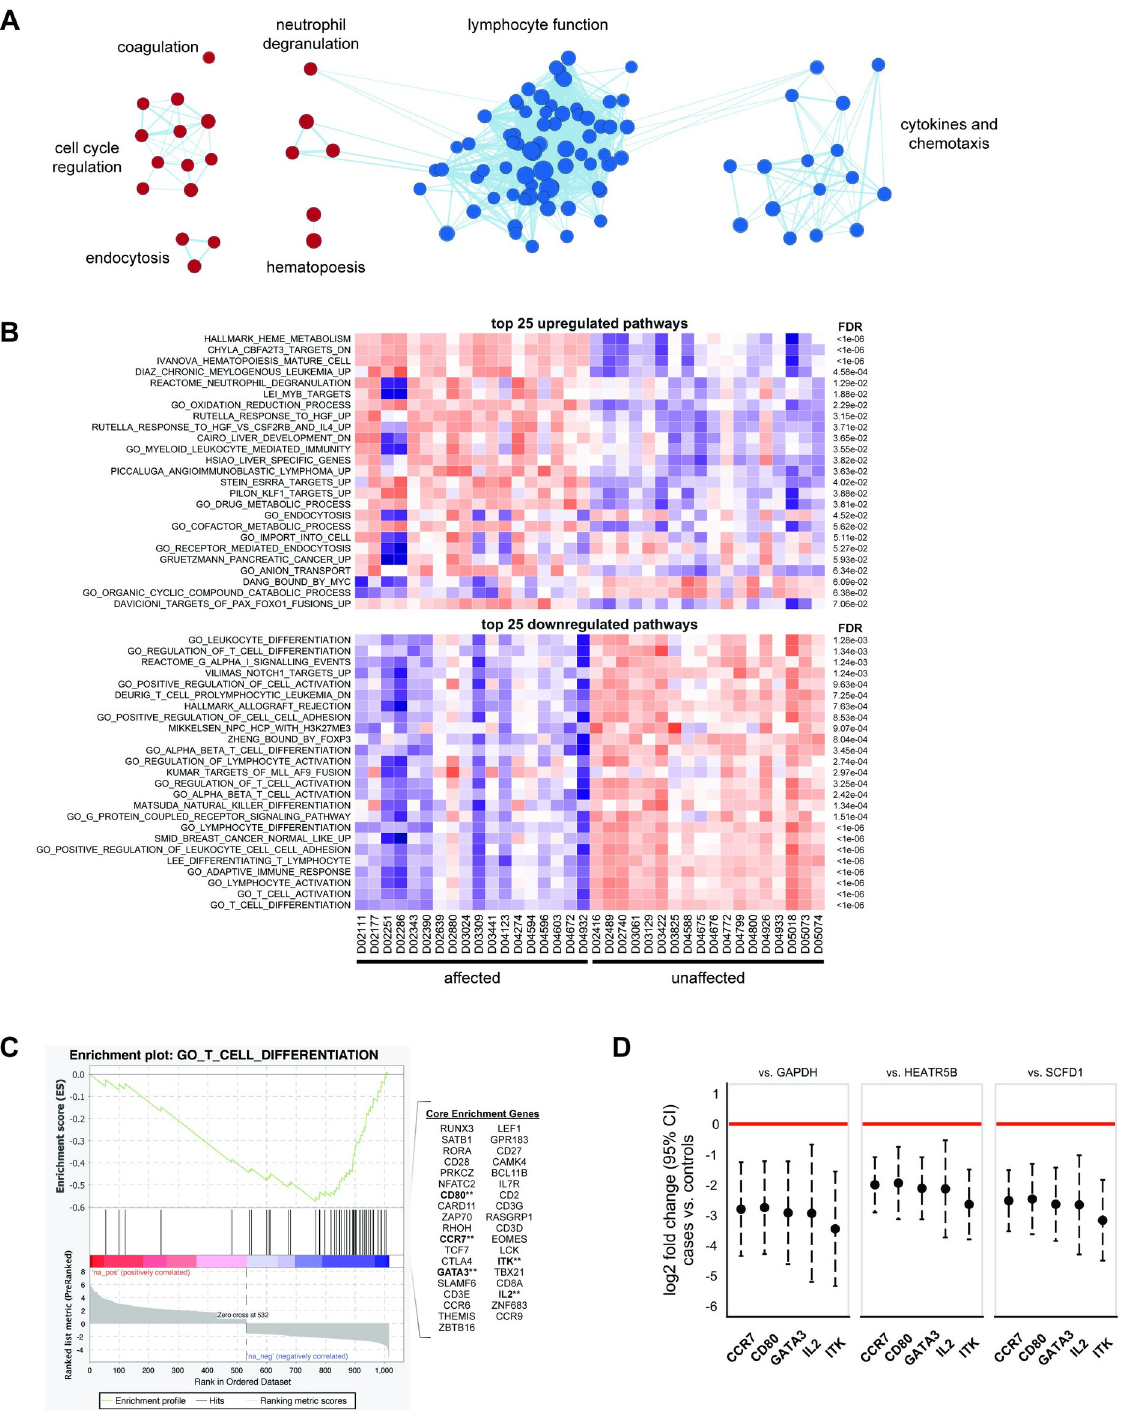
Fig 2. Pathway analysis. (A) Cytoscape enrichment map of over- and underexpressed GSEA pathways in dogs with IMHA. Each dot represents a GSEA pathway, and lines represent interconnectedness. Red dots represent overexpressed pathways and blue dots represent underexpressed pathways. Groupings of pathways are labeled by common activities or functions. (B) Top 25 over- and underexpressed pathways in dogs with IMHA. Overexpressed pathways are shown on the top and underexpressed pathways are shown on the bottom. A projection of enrichment of genes within each pathway from ssGSEA is shown for each dog, with affected dogs on the left and unaffected dogs on the right; red represents higher expression and blue represents lower expression. FDR p-values for pathway enrichment are shown on the right. (C) GSEA enrichment plot for “GO T cell differentiation,” which was the most underexpressed pathway in our dataset. Genes